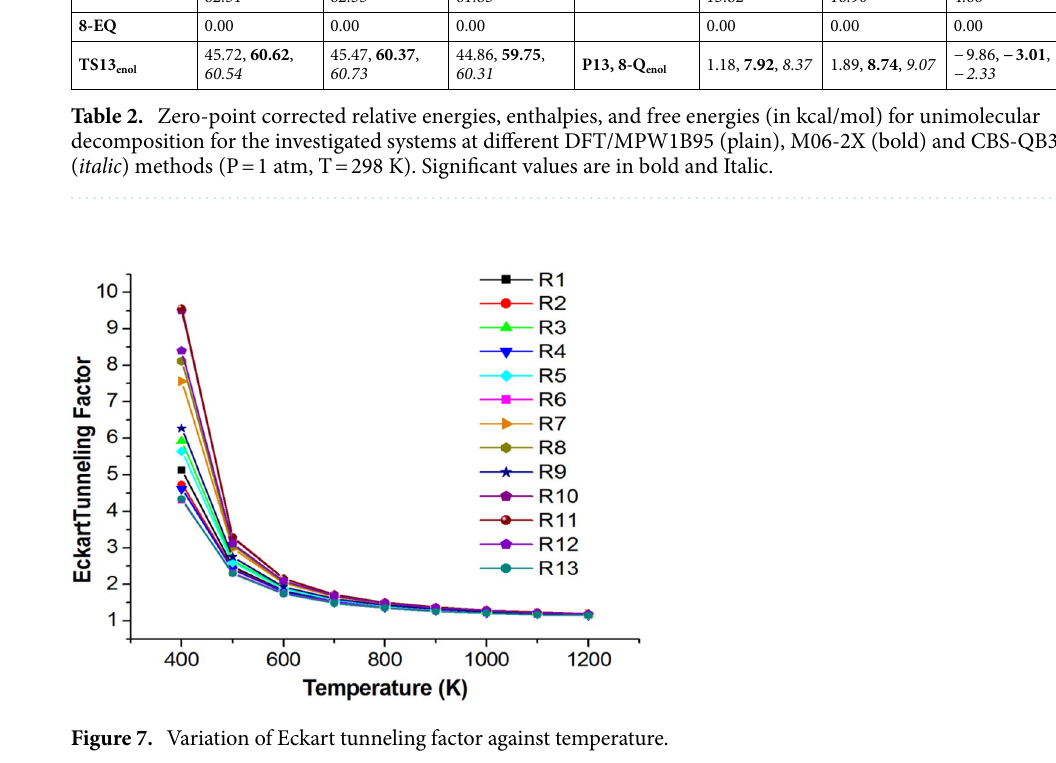
Figure 7. Variation of Eckart tunneling factor against temperature.